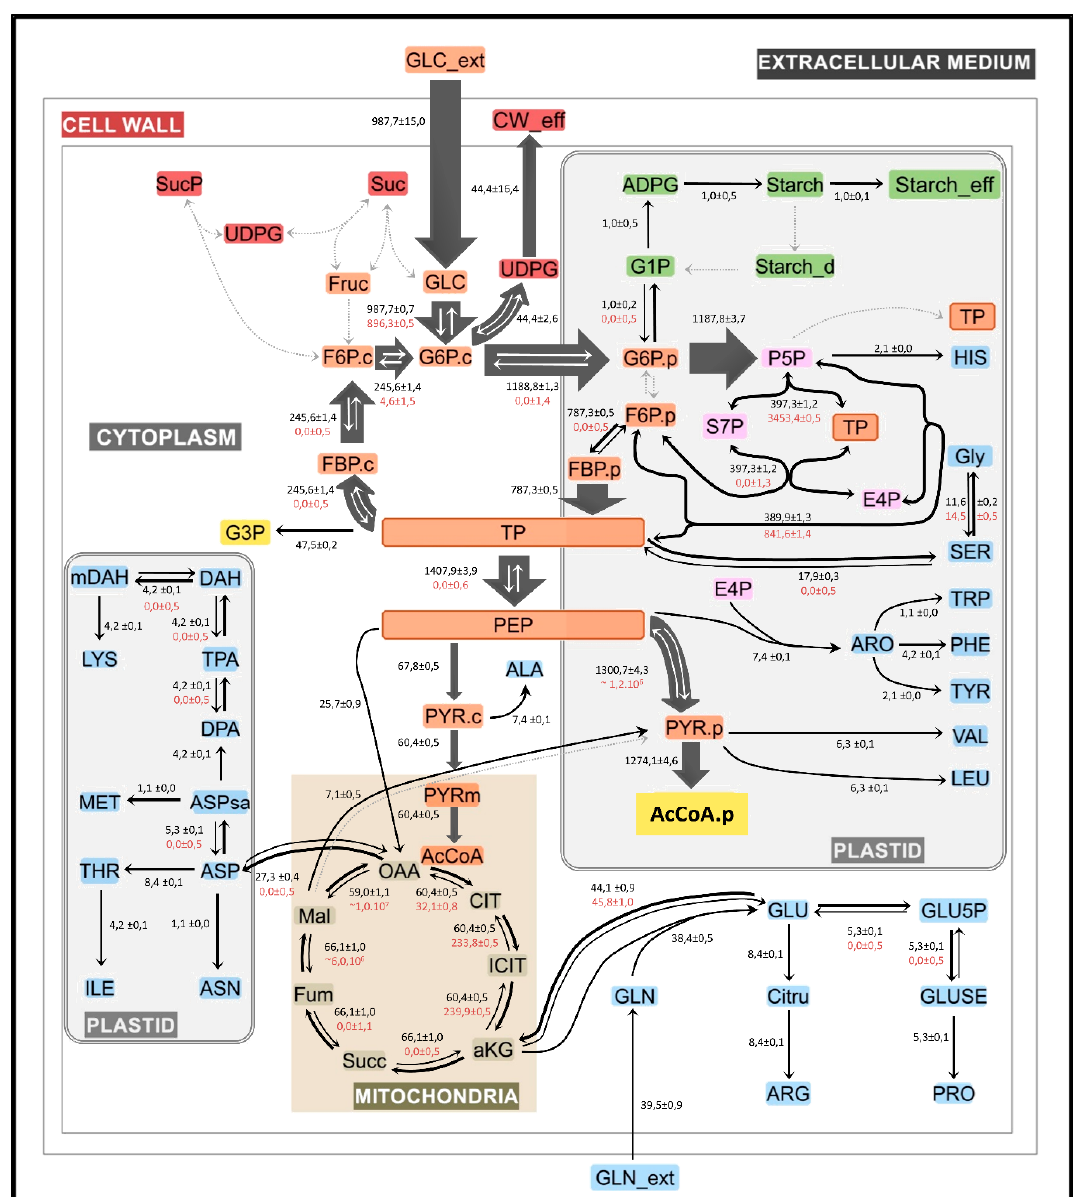
Figure 5. Metabolic network and fluxes in flax embryos during maturation stage. The scheme presented is a simplified representation of the central carbon metabolism in flax embryos during fatty acid synthesis and TAG accumulation. Cytosolic and plastidial metabolites are specified by subscripts c and p, respectively, if the model distinguishes such subcellular species. All reactions, metabolites and abbreviations are available in Supplementary Tables S3 and S4. Values reported are the best fit obtained by INCA software using three parallel labeling experiments (53 metabolites and six extracellular fluxes). The average and standard deviation are calculated from four independent experiments. Fluxes are expressed in mmol/gDW/d ± confidence interval. The set of estimated flux values calculated by INCA software are presented in Supplementary Table S6. The metabolic map was drawn using the Omix software [41].